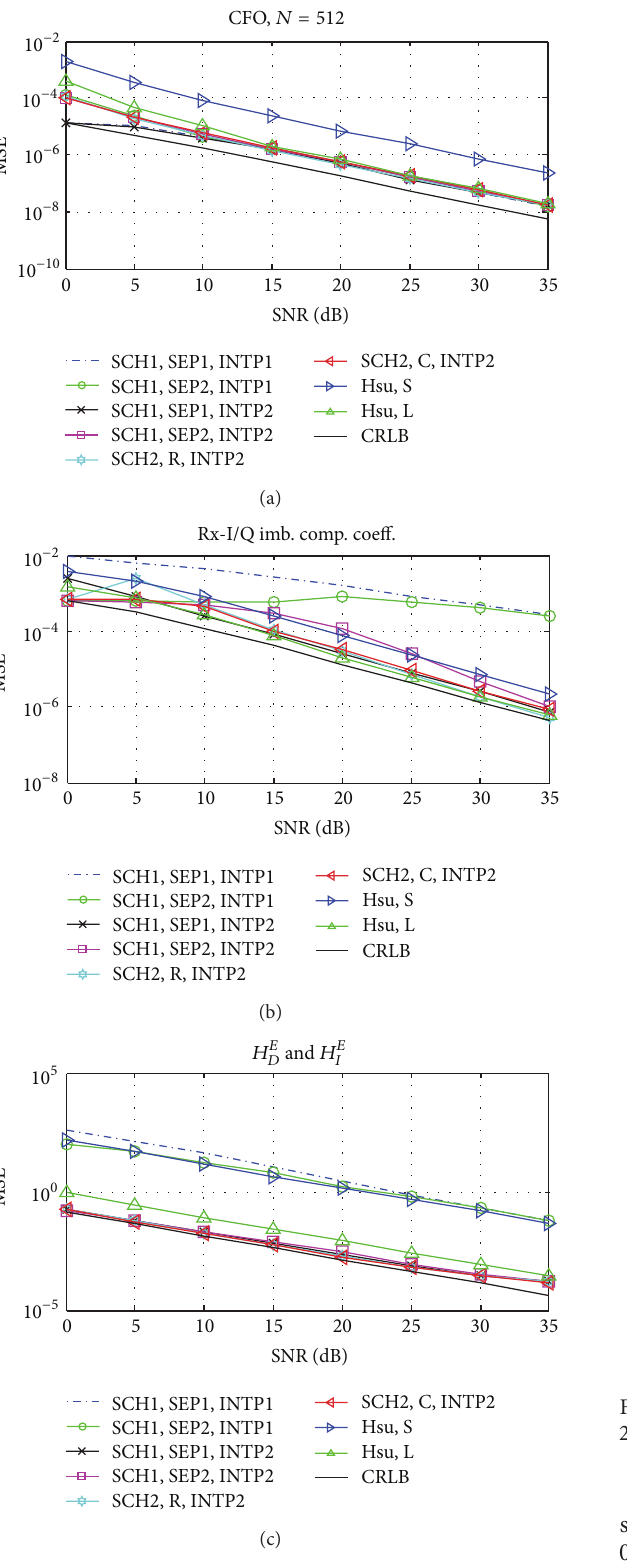
Figure 8: Estimation MSE as a function of SNR, 𝑁 𝐼 = 1, 𝑁 = 512, and 𝜖 = 0.5 .